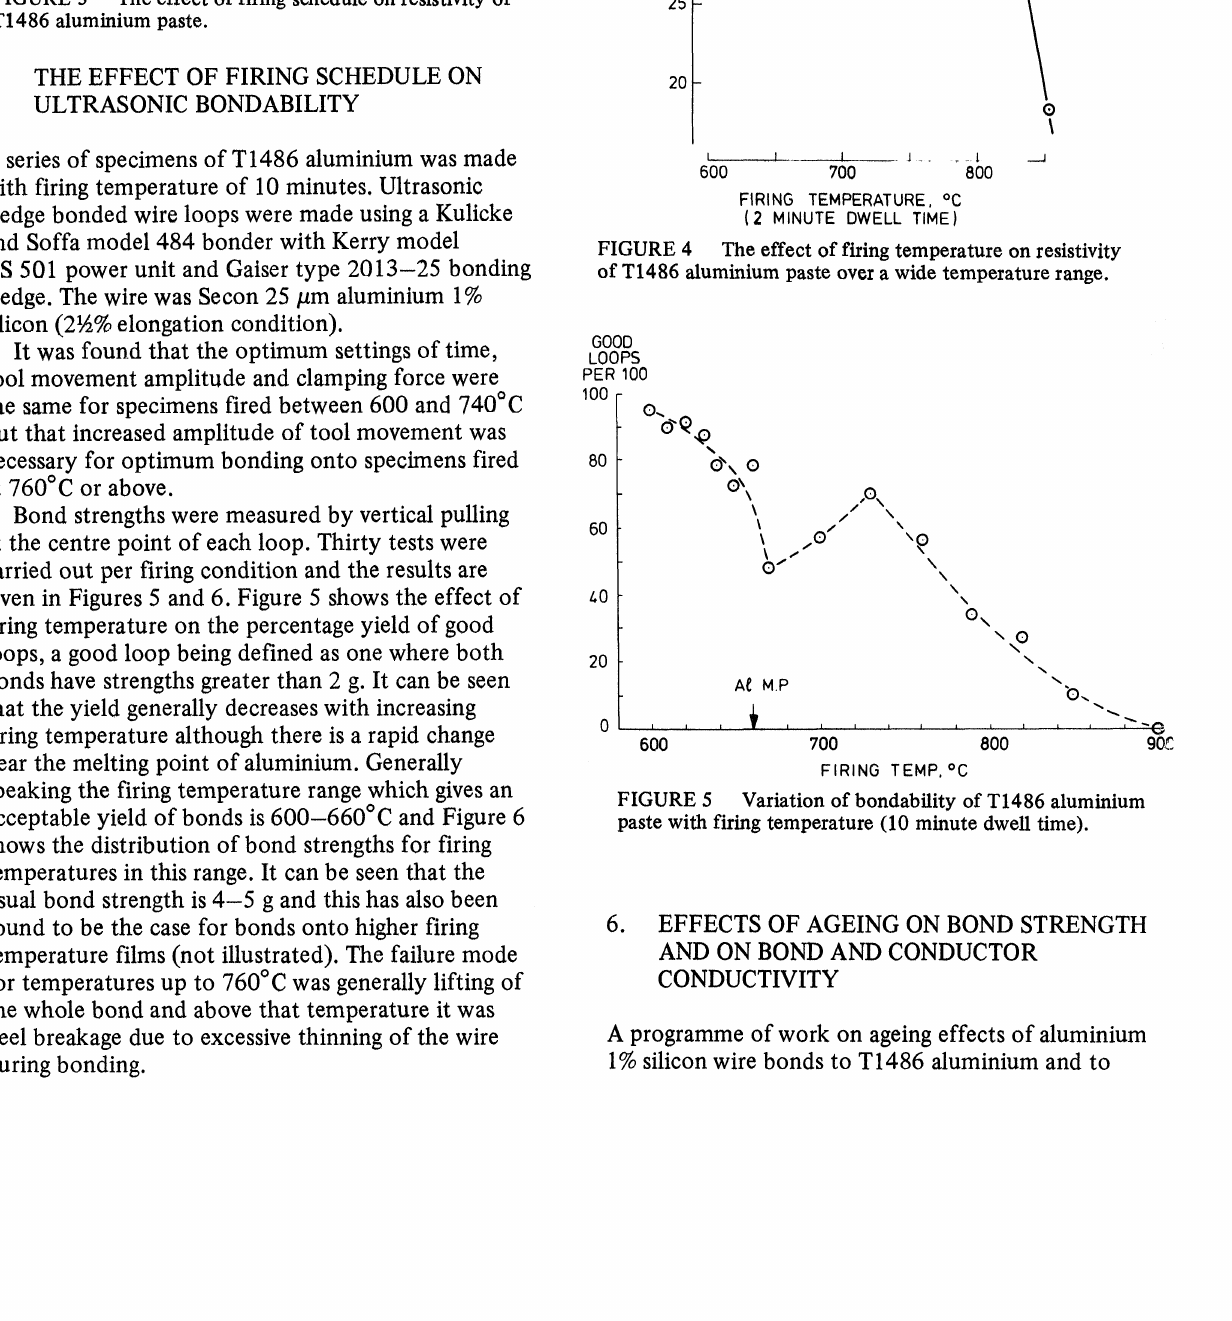
The effect of firing schedule on resistivity of T1486 aluminium paste. 5.